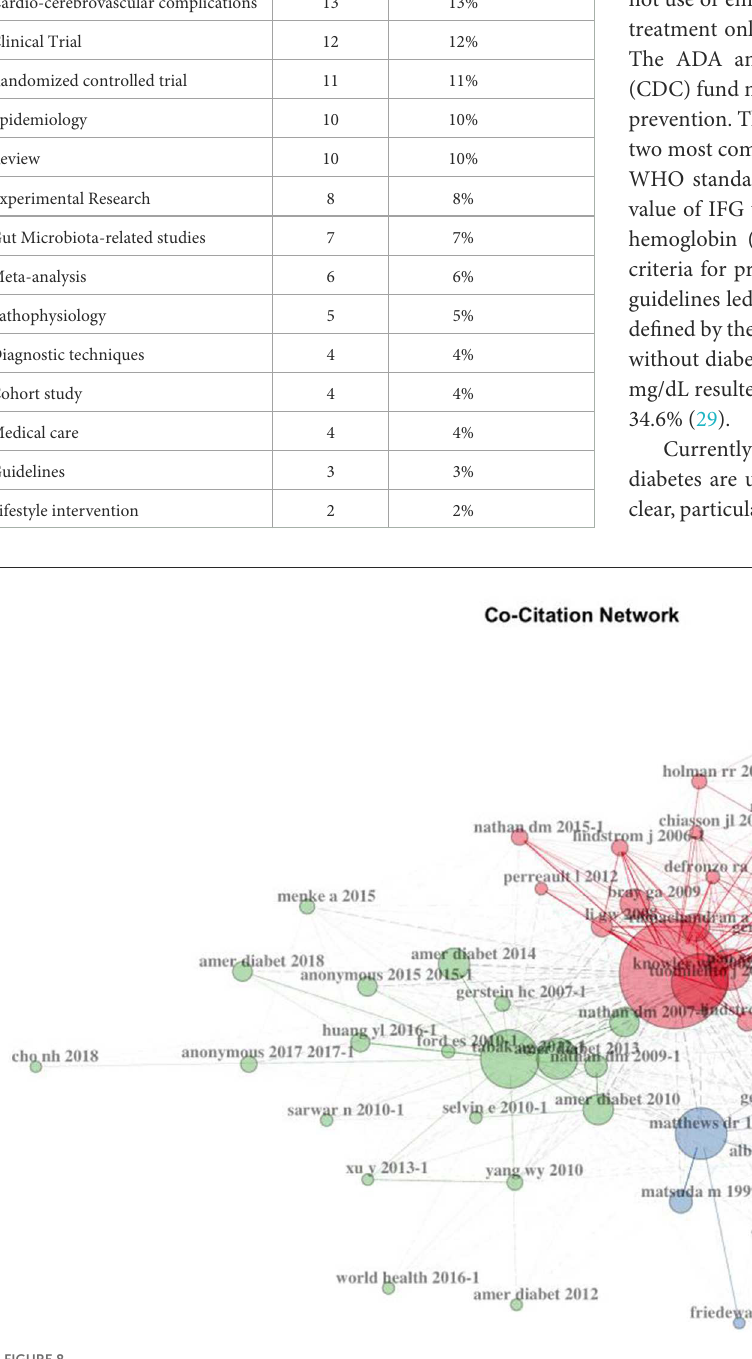
FIGURE8 Co-citation